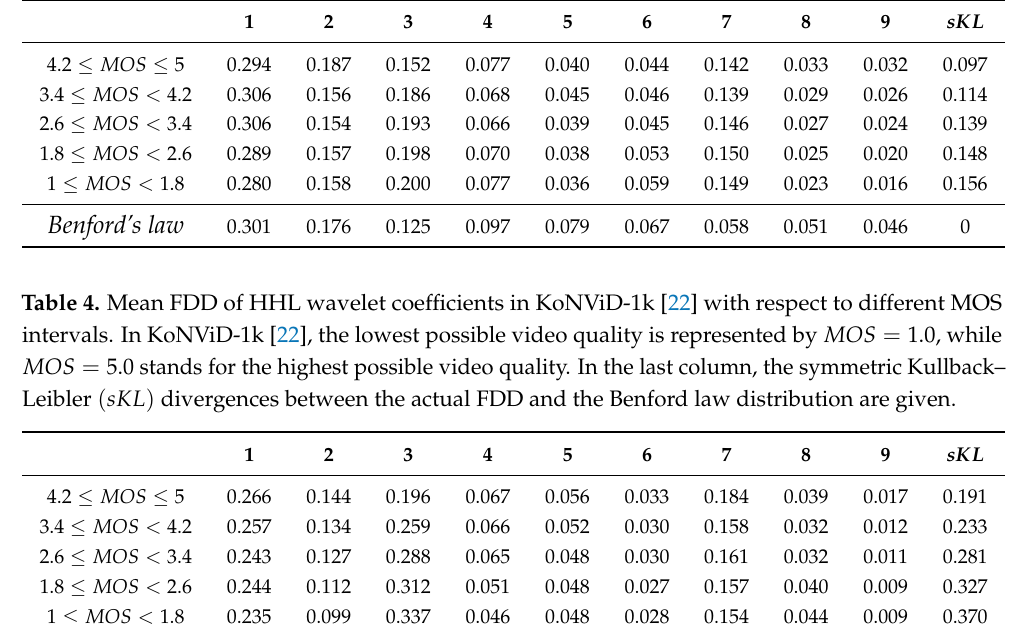
Table 3. Mean FDD of HLL wavelet coefficients in KoNViD-1k [22] with respect to different MOS intervals. In KoNViD-1k [22], the lowest possible video quality is represented by MOS = 1.0, while MOS = 5.0 stands for the highest possible video quality. In the last column, the symmetric Kullback– Leibler ( sKL ) divergences between the actual FDD and the Benford law distribution are given.